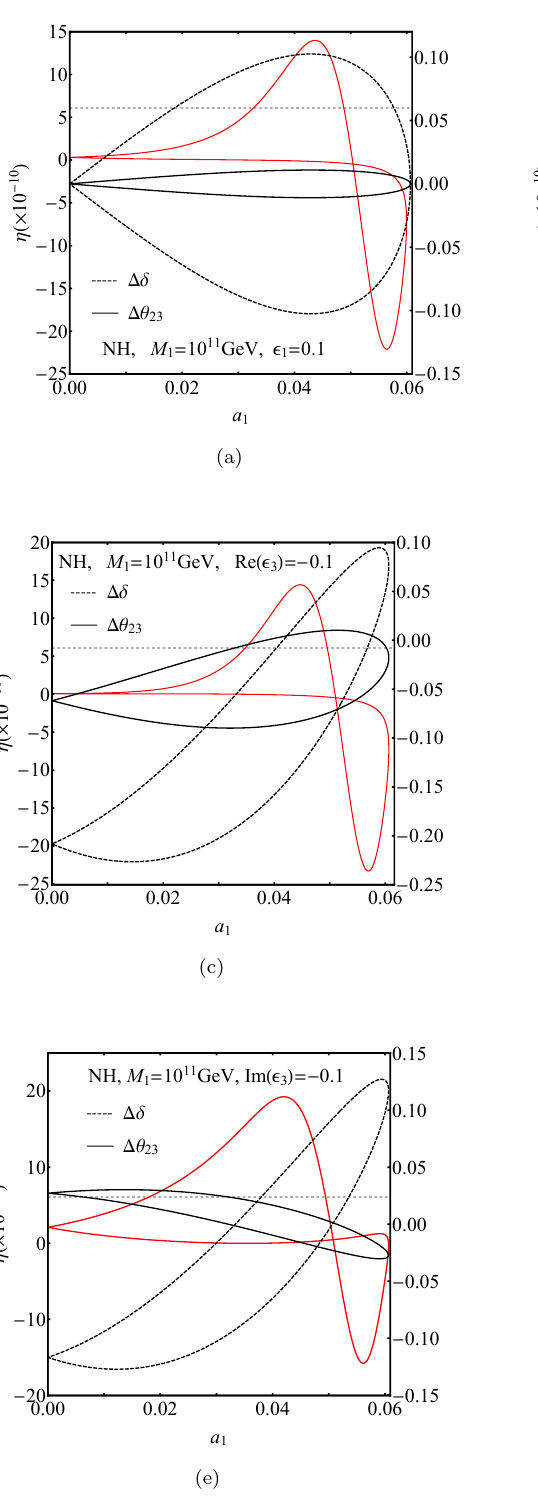
(as functions of a ) from the parameter choices shown in 23 1